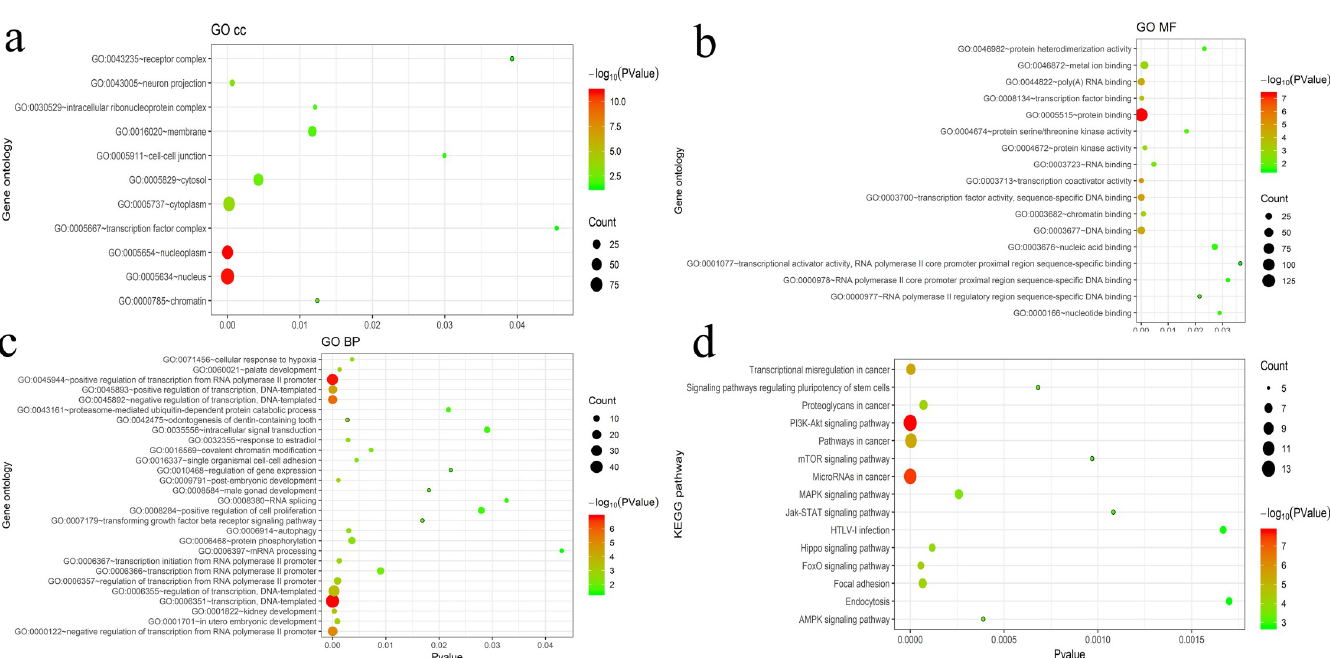
Fig 7. Biological function and KEGG pathway analyses of target genes. (a) The enriched GO cellular component terms of target genes. (b) The enriched GO molecular function terms of target genes. (c) The enriched GO biological process terms. (d) The enriched pathways of the target gene determined by KEGG pathway analysis. GO, Gene ontology; KEGG, Kyoto Encyclopedia of Genes and Genomes.